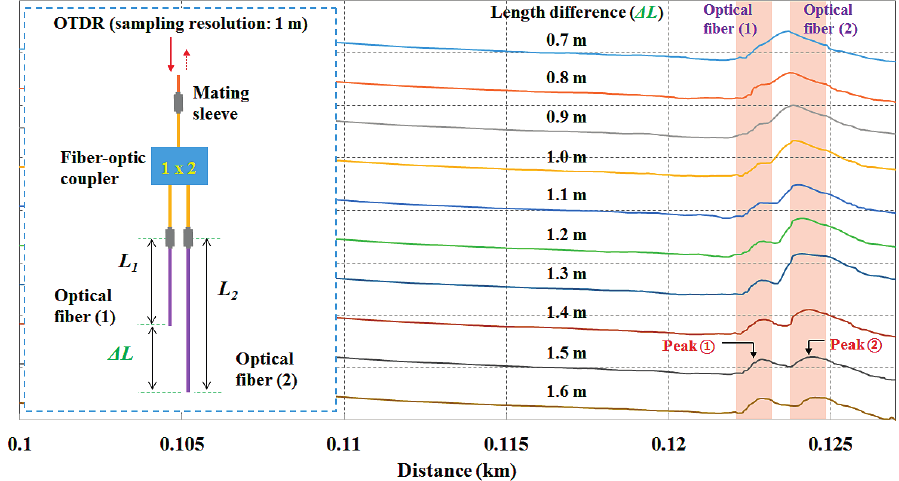
Figure 8. Variation of each optical peak with change in the length difference between the two optical fibers.